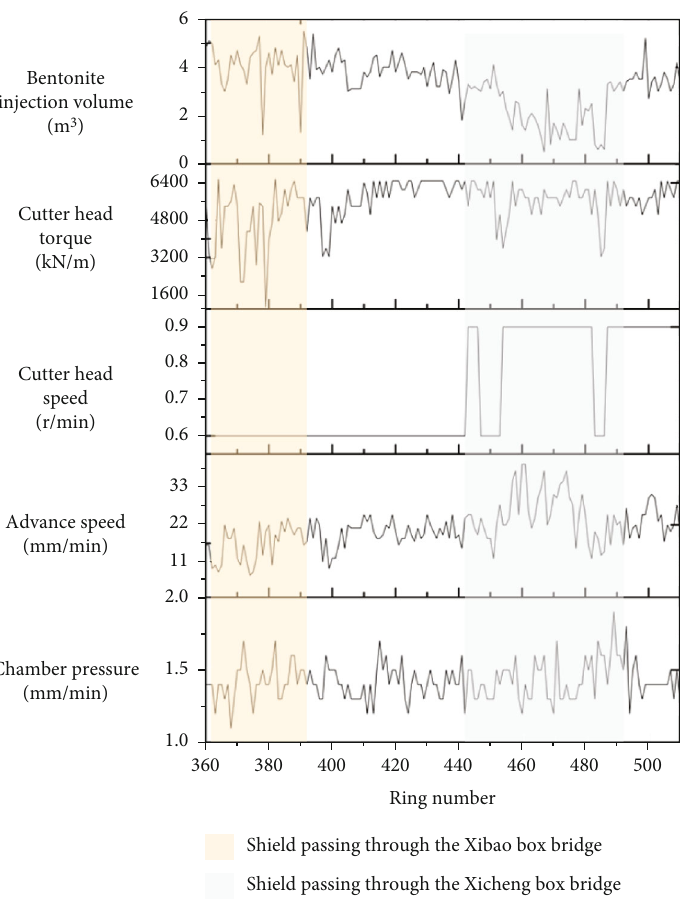
Figure 16: Driving parameters of shield tunneling under box bridges.